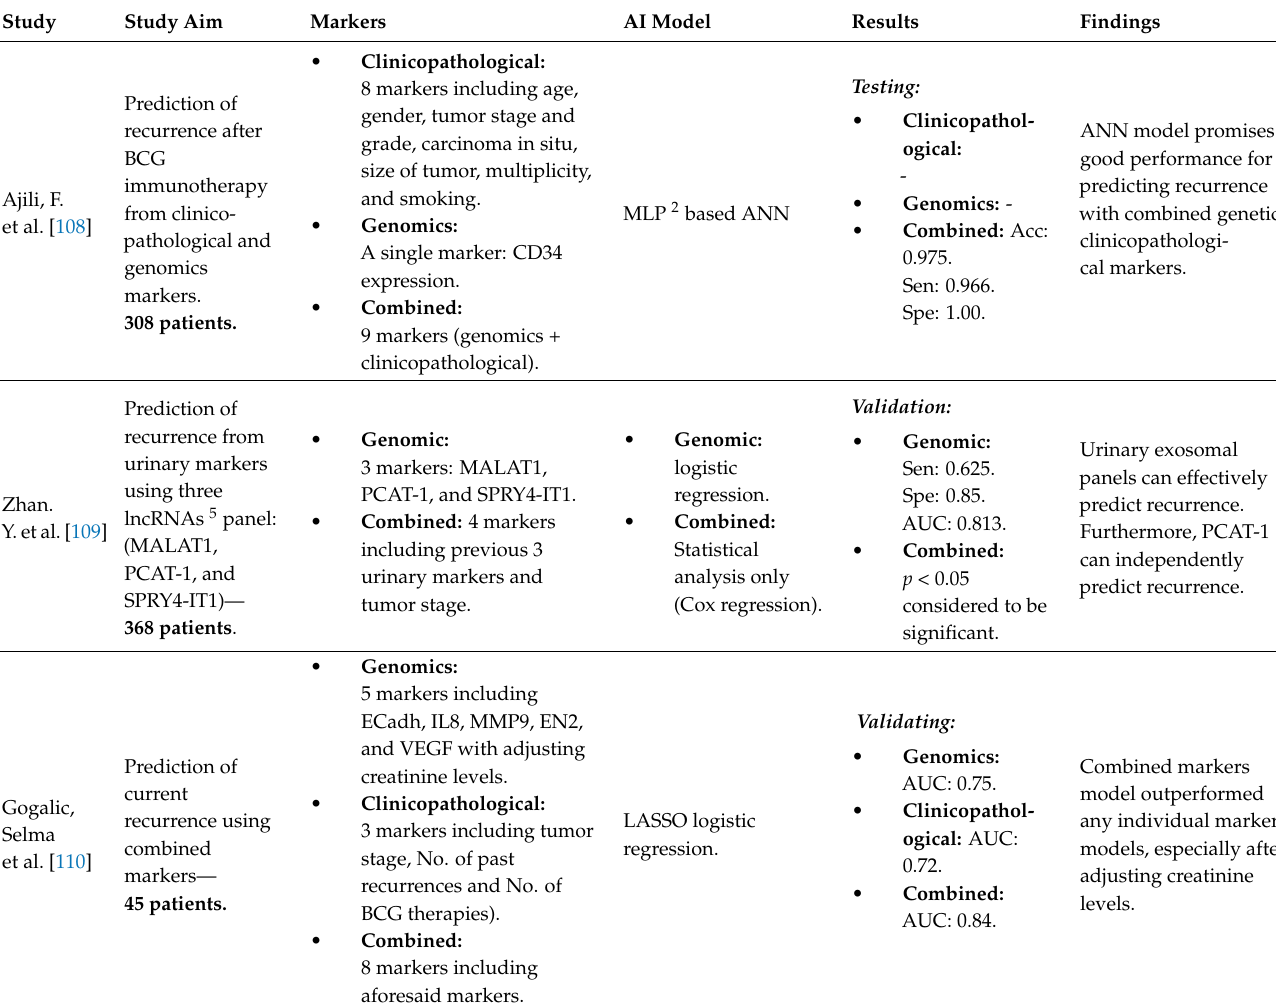
Combined markers model